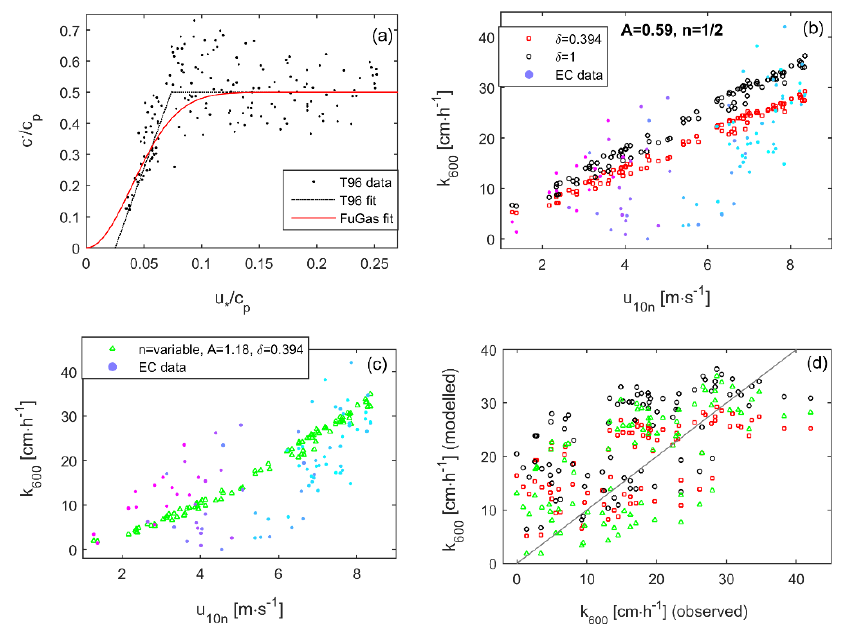
Figure 7. Estimation of k wind term adapting the algorithm by Esters et al. [30] based on the formulation by Terray et al. [53] for the ε depth profile [Equation (19)]. ( a ) Terray et al. [53] function and FuGas re-fit; ( b ) and ( c ) Esters et al. [30] calibration; ( d ) Esters et al. [30] validation against EC-derived transfer velocities. (T96 data) Terray et al. [53] data, (T96 fit) Terray et al. [53] fit, and (FuGas fit) FuGas re-fit of effective wave velocity. (EC data) transfer velocities estimated from the Eddy-Covariance fluxes.